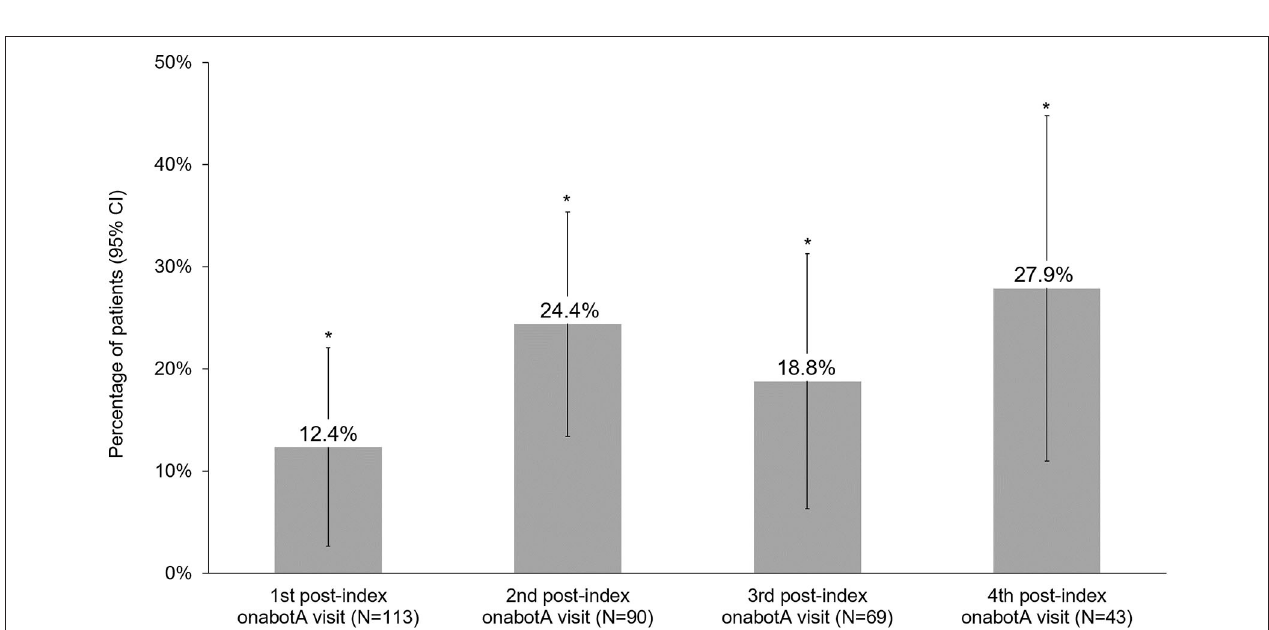
FIGURE 4 | Percent reduction in monthly headache frequency prior to onabotulinumtoxinA treatment and during 12 months of combination treatment with onabotulinumtoxinA and a CGRP mAb. CGRP, calcitonin gene-related peptide; CI, confidence interval; MHD, monthly headache days; onabotA, onabotulinumtoxinA. a Difference from baseline. *Indicates statistical significance (i.e., 95% CI do not include zero).